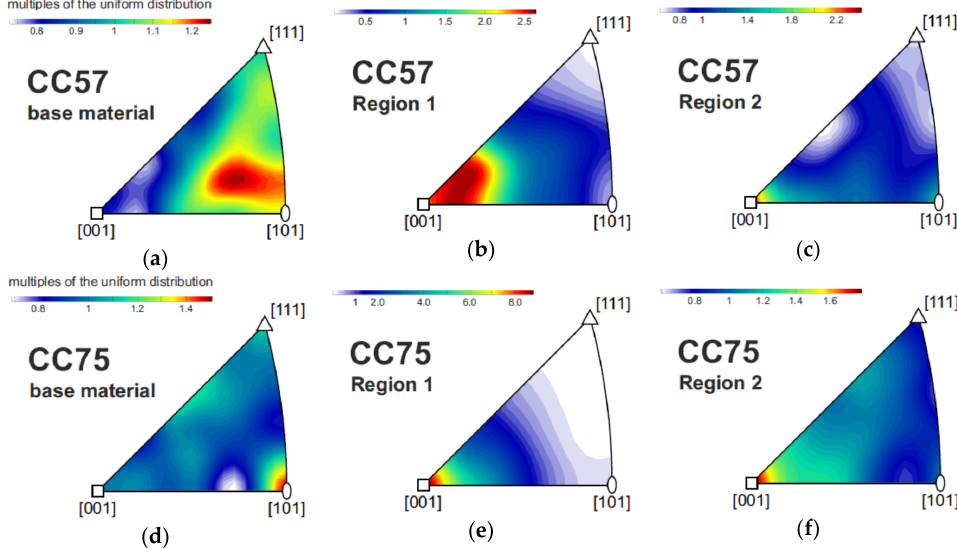
Figure 4. ODF (orientation distribution function) calculated by using global texture data presented within the standard triangle for the inverse pole figure of the sample surface normal in CC57 and CC75 (Figure 4a–c and Figure 4d–f, respectively). Texture was determined for the initial material, R1 and R2, respectively (from Figure 4a,d to Figure 4c,f).